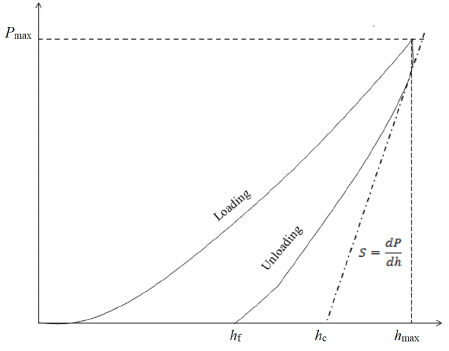
Figure 1. Curve of loading and unloading used to measure films mechanical properties.